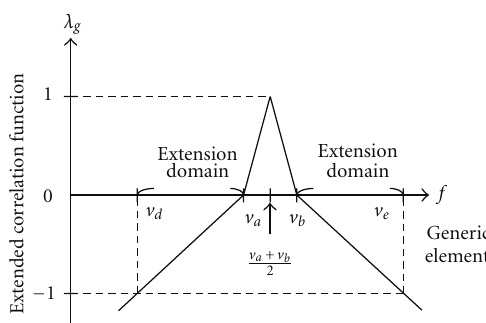
Figure 1: Schematic diagram of elementary correlation function.